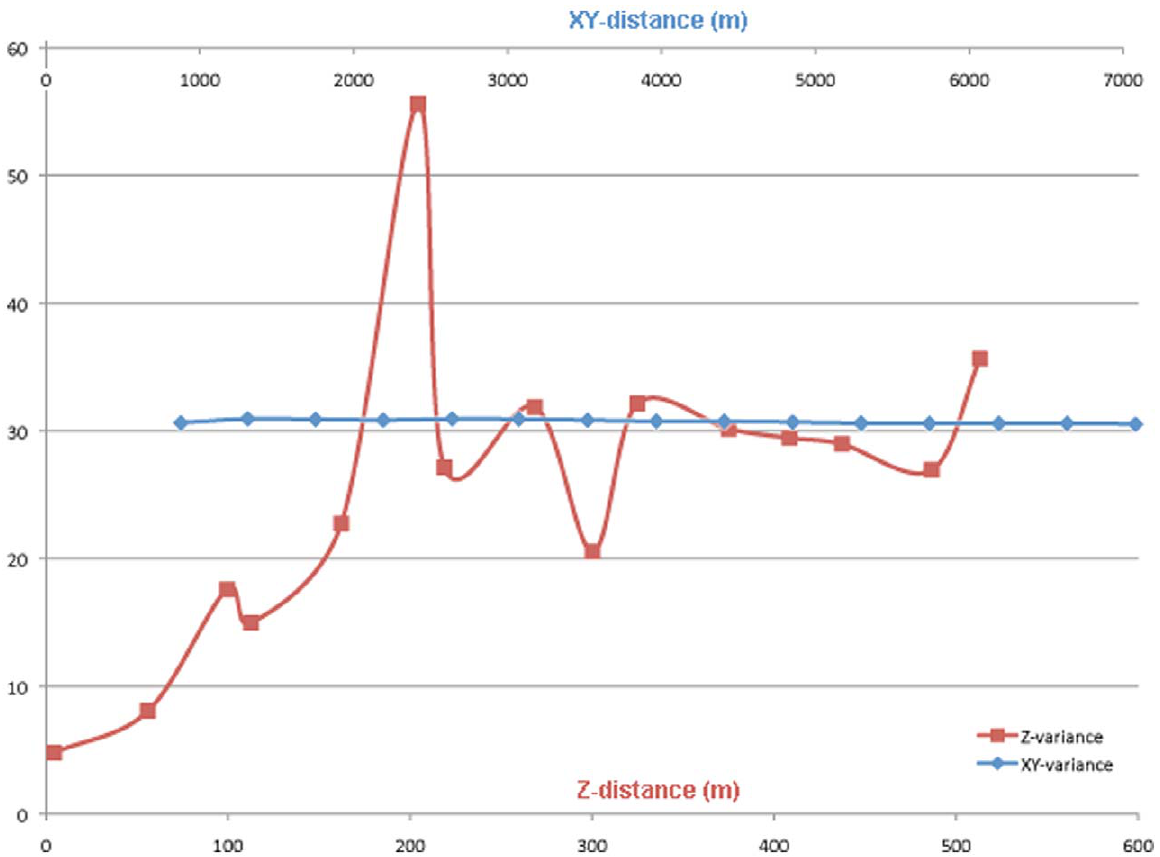
Figure 2. Semivariograms of acoustic backscatter with vertical (depth) and horizontal distances (x,y). Lag distance is on the x-axis with semivariance on the y-axis.